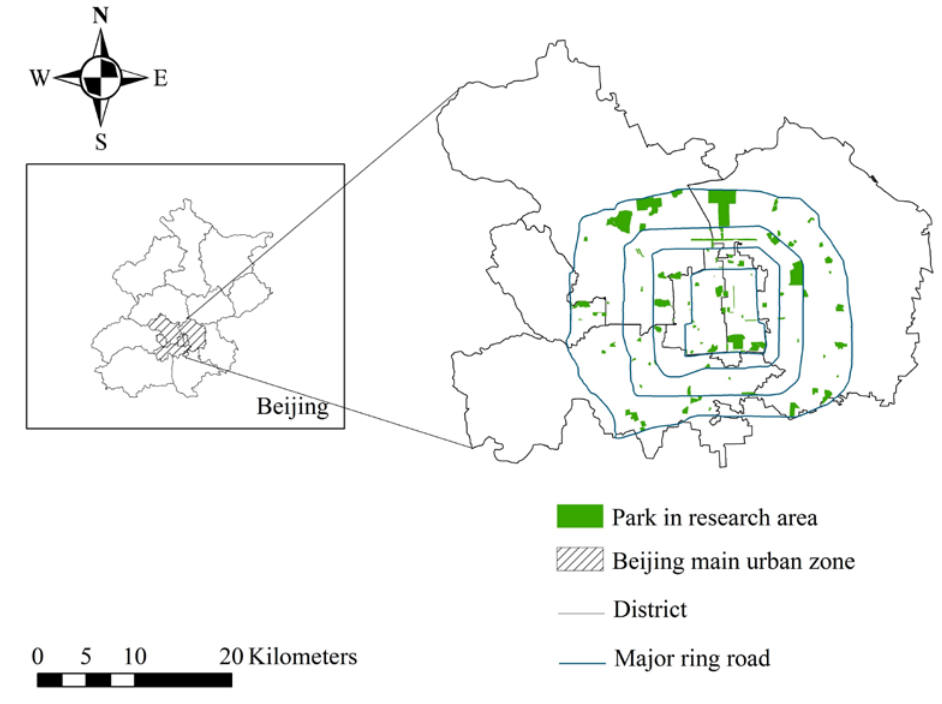
Figure 1. The location of urban parks within the fifth ring road of Beijing.